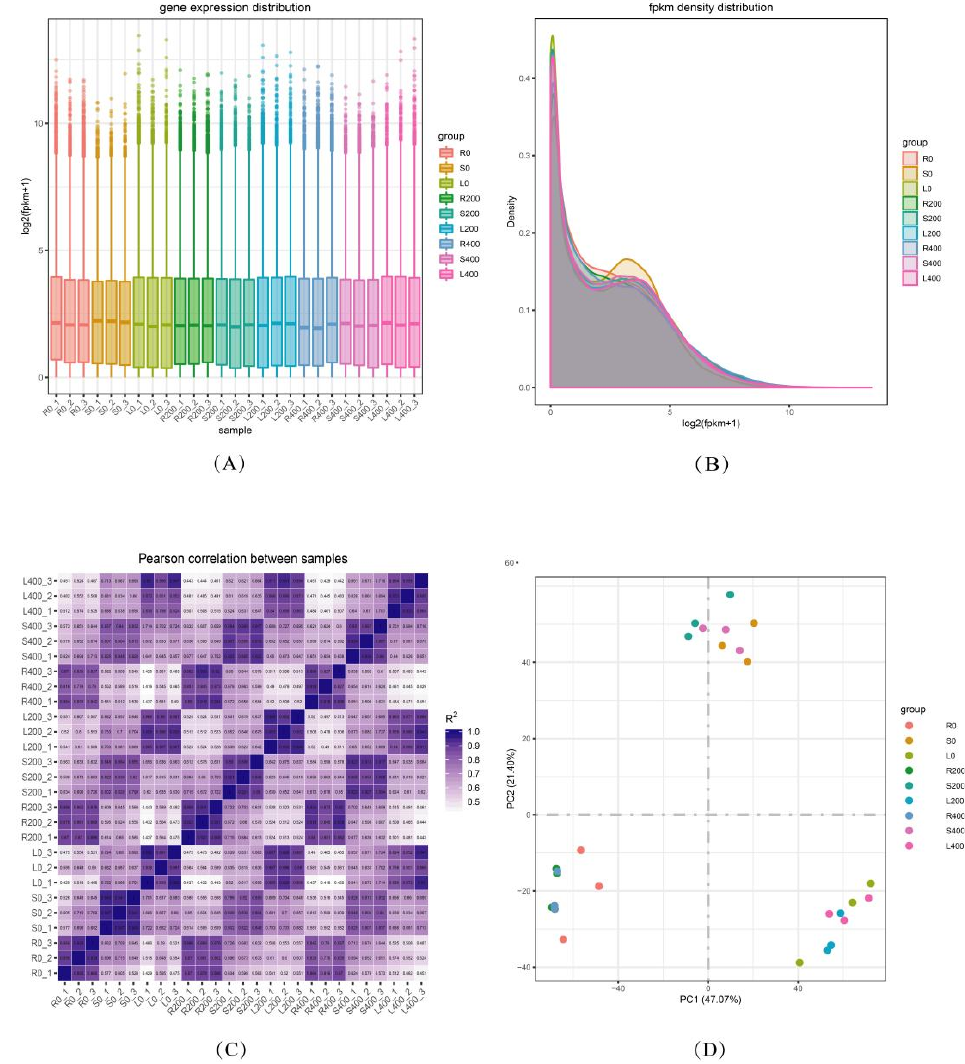
Figure 1. Quantitative analysis of gene expression. ( A ) Distribution box plot of gene expression levels in different samples. ( B ) Density distribution diagram of FPKM values. ( C ) Correlation heat map. ( D ) PCA diagram of samples.